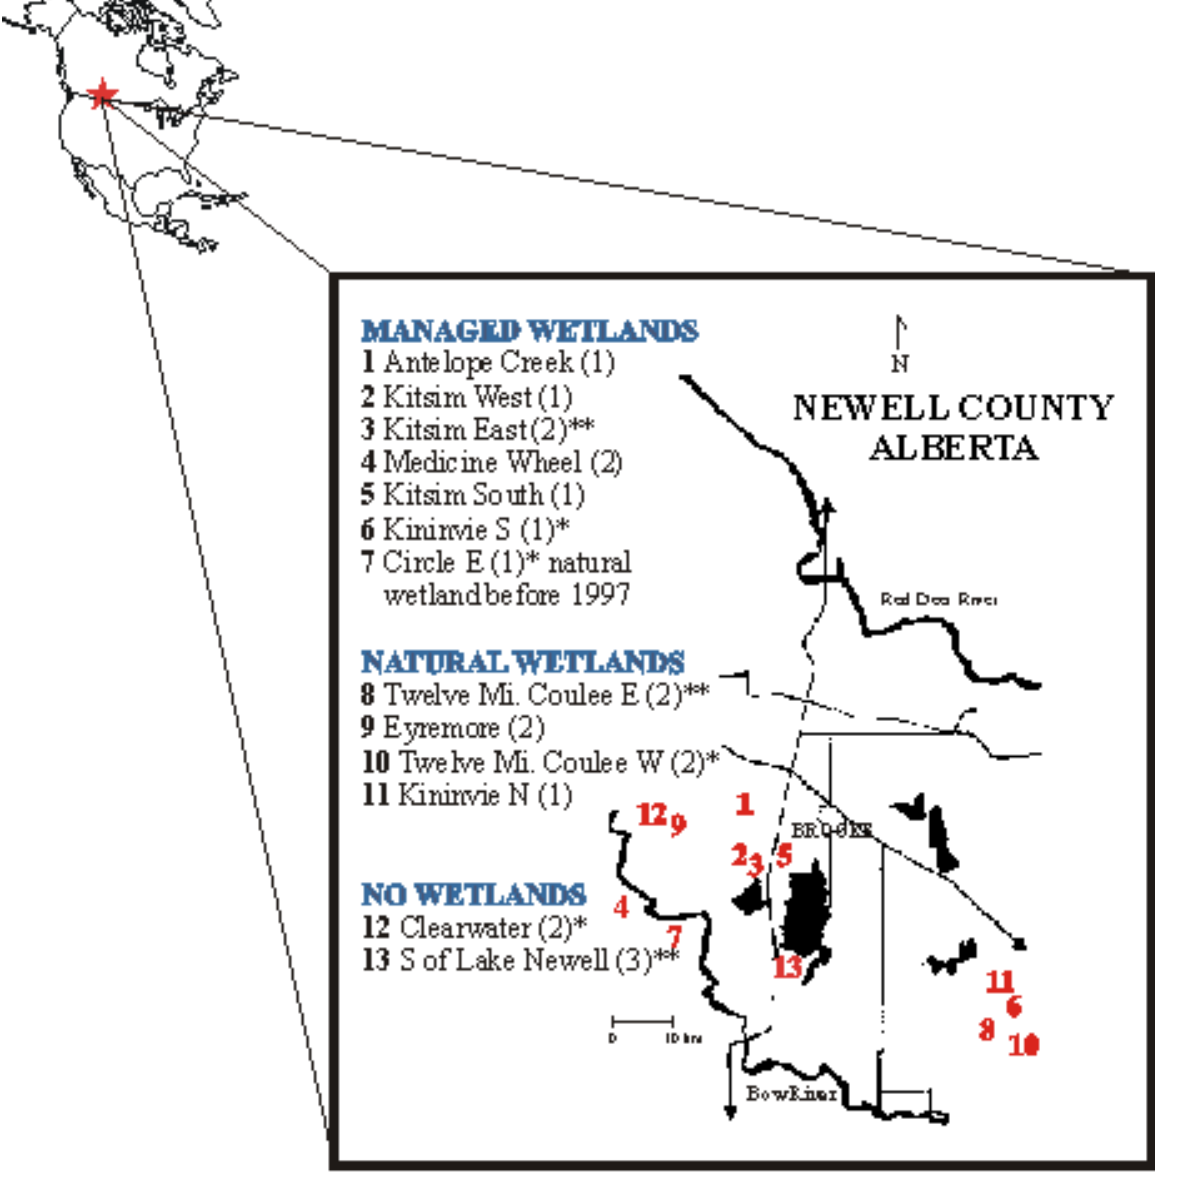
Fig. 1. Map of study area in southern Alberta, with survey sites listed as being in areas of managed, natural, or no wetland basins. Numbers in parentheses after location represent the number of 5 km long routes in that area (and see Table 1). Asterisks after site names show survey sites that were nest-searched between 1998 and 2000 (1 asterisk = one 2-km 2 area of survey route was searched; 2 asterisks = one 2-km 2 area of each of two survey routes were searched). Dark lines and splotches represent rivers and